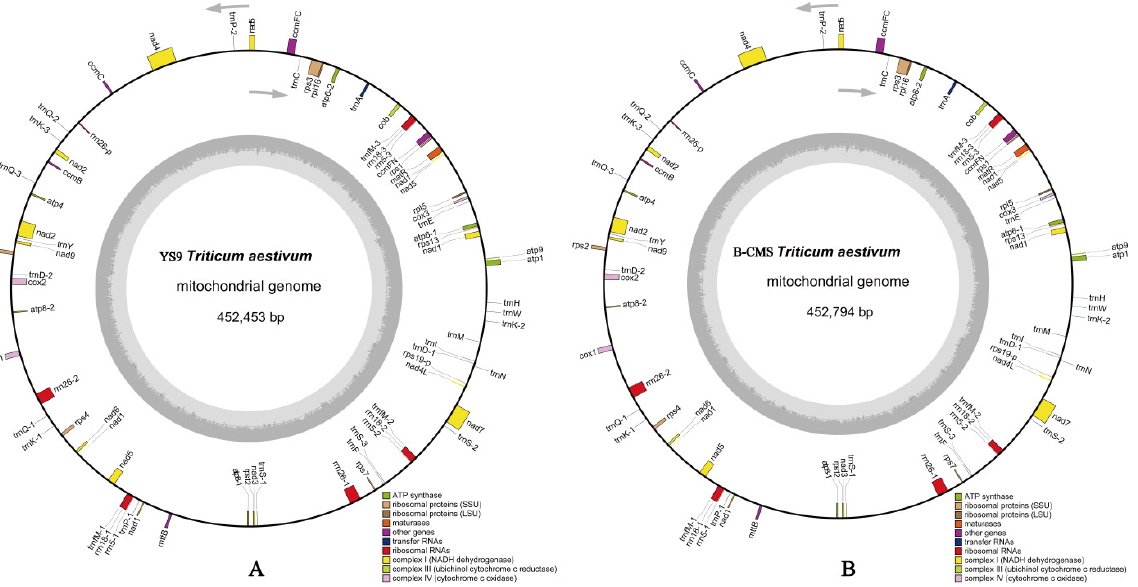
Figure 3. The two circular mitochondrial genomes of the wheat CMS line and its maintainer line, ( A ) the maintainer line YS9, ( B ) the B-type CMS line. Genes shown on the inside of the circle are transcribed clockwise whereas genes on the outside are transcribed counter-clockwise; different functional genes are indicated by different colors. GC content is conveyed on the inner circle by dark gray shading.